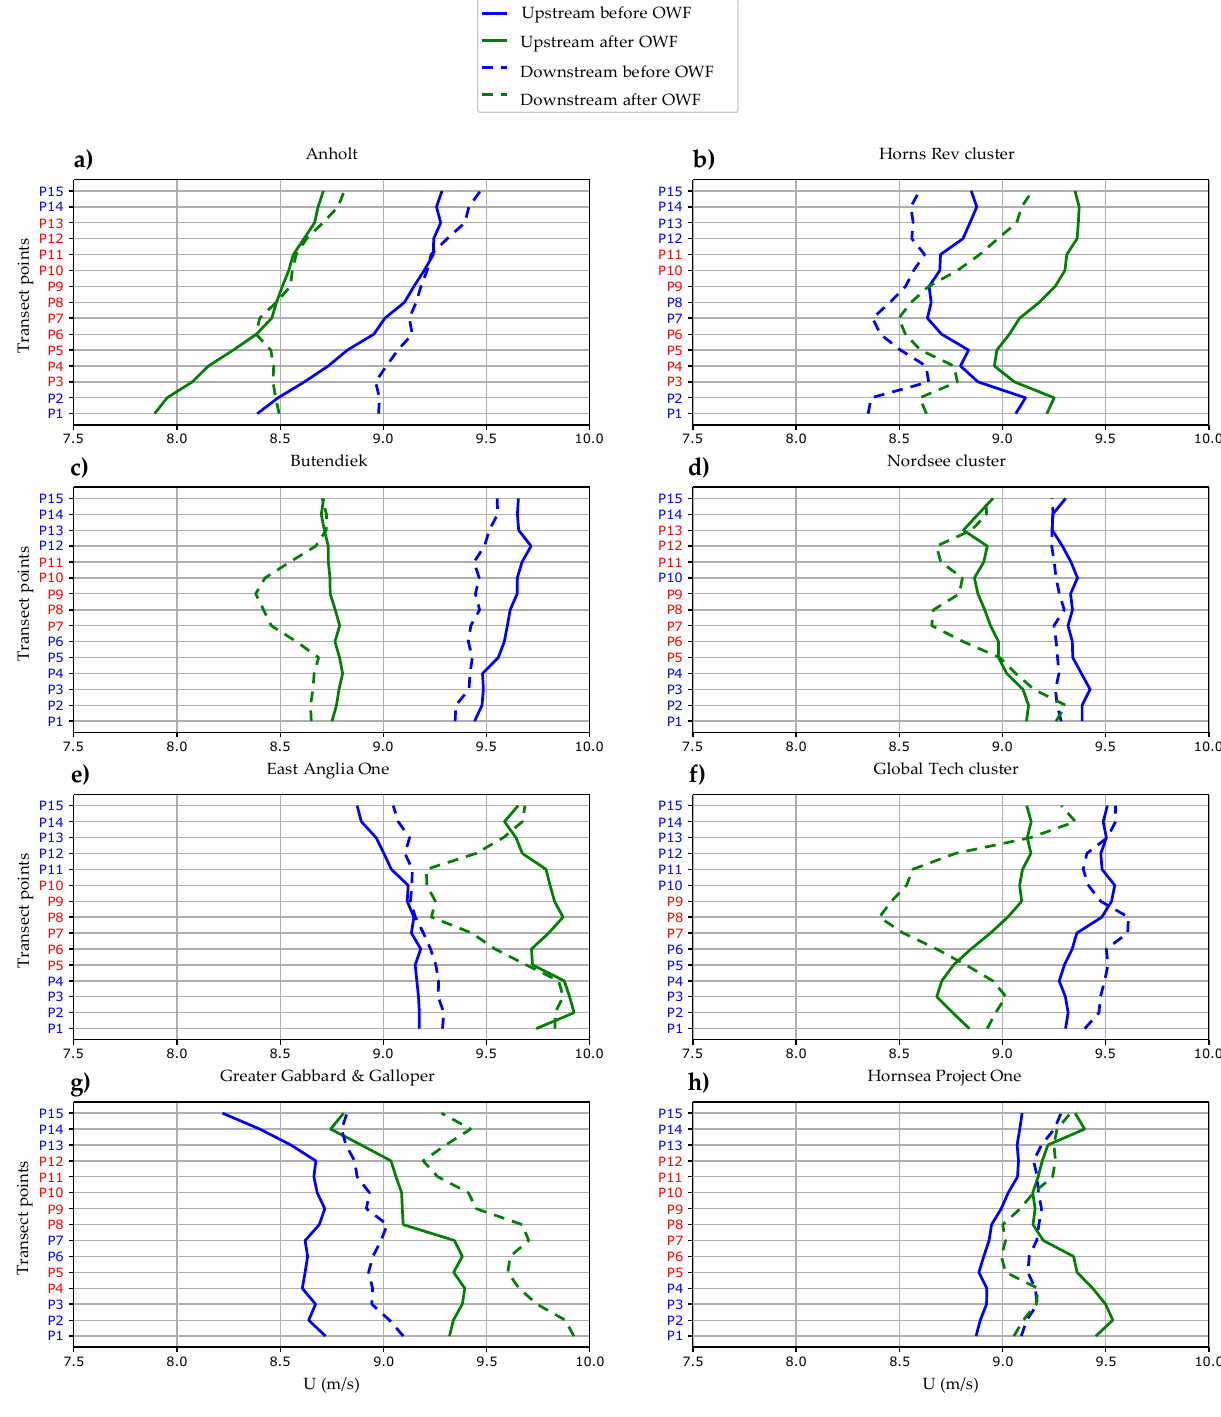
Figure 4. Mean wind speed ( U ) for westerly winds over the OWFs and clusters. The blue and green curves refer to periods before and after OWF commissioning, respectively. Solid lines represent the upstream side and the dashed lines the downstream side of the OWFs. The red-labeled transect points are those located directly upstream/downstream of the wind turbines (see also Figure 3). ( a ) Anholt; ( b ) Horns Rev cluster; ( c ) Butendiek; ( d ) Nordsee cluster; ( e ) East Anglia One; ( f ) Global Tech cluster; ( g ) Greater Gabbard & Galloper; ( h ) Hornsea Project One.